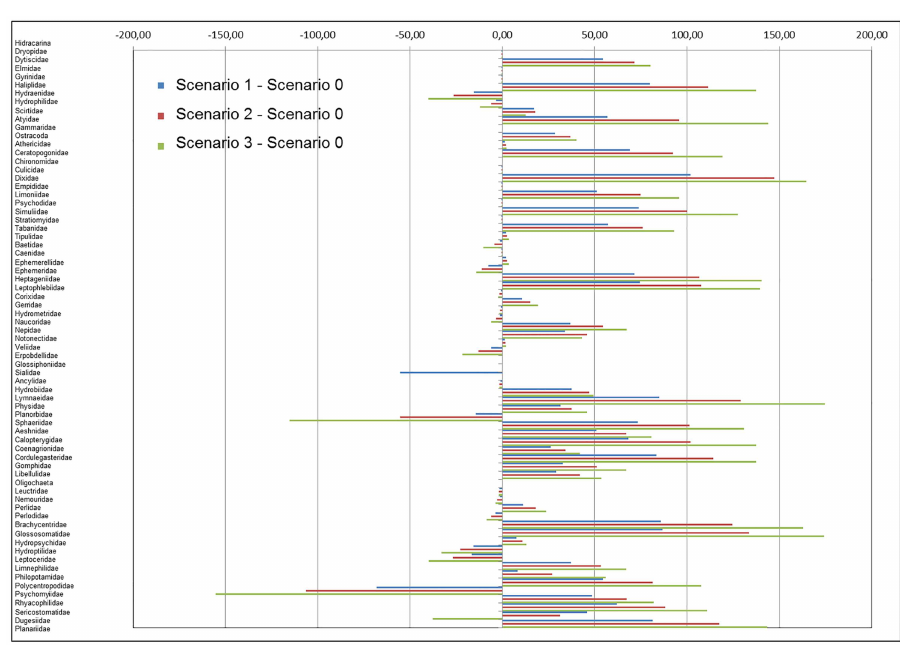
Fig 6. Shifts in altitudinal distribution range for each taxon. Differencein altitudinaldistribution range (mean altitude) of taxa present with a probabilityof capture (cid:21) 50%, betweeneach scenario modelled: scenario 1 (+1.70˚C and -10% flow), scenario2 (+2.45˚C and -20% flow), and scenario 3 (+3.30˚C and -30% flow), and scenario0 (current conditions)